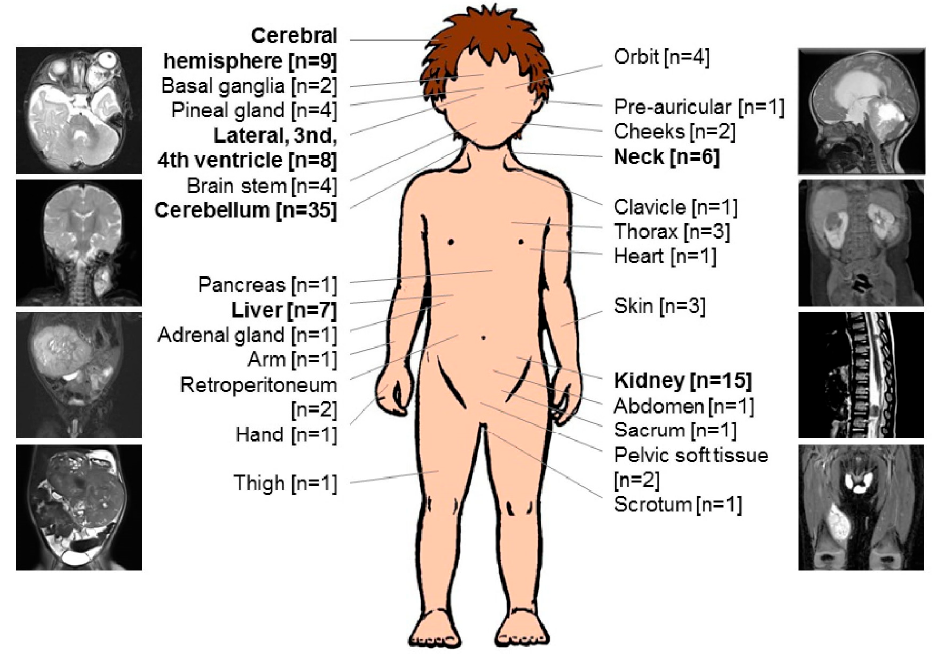
Figure 1. Anatomical localizations of infants with malignant rhabdoid tumor. Anatomical localization of infants with MRT ( n = 100), included n = 17 synchronous tumors, registered between 2005 and 2020 in EU-RHAB database. The most common localization detected in this series, are highlighted in bold. Table 1. Clinical characteristics of 100 infants with malignant rhabdoid tumors.